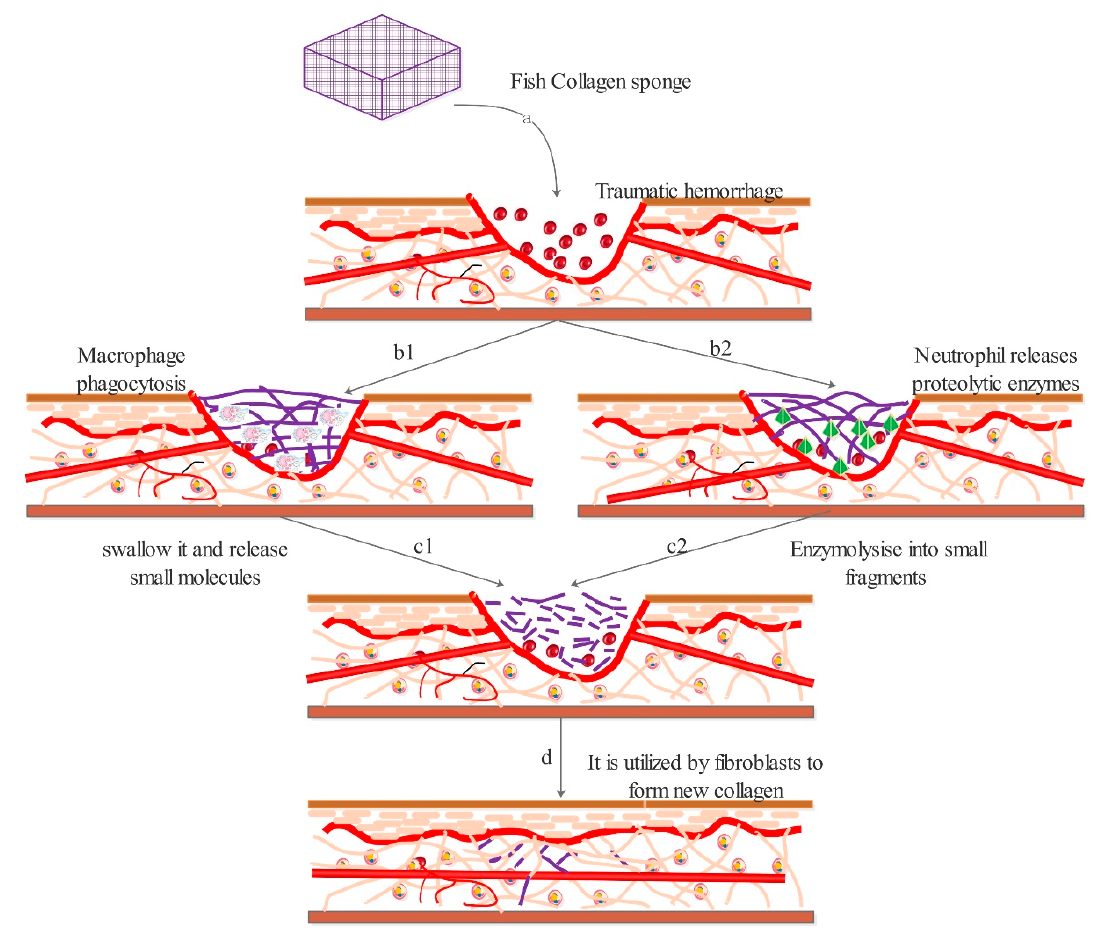
Figure 8. Wound regeneration mechanism of collagens ( a. Collagen covers the wound. b1 , c1 . Decomposed by phagocytosis of macrophages. b2 , c2 . Decomposed by enzymes. d . Decomposed peptides participate in wound regeneration).